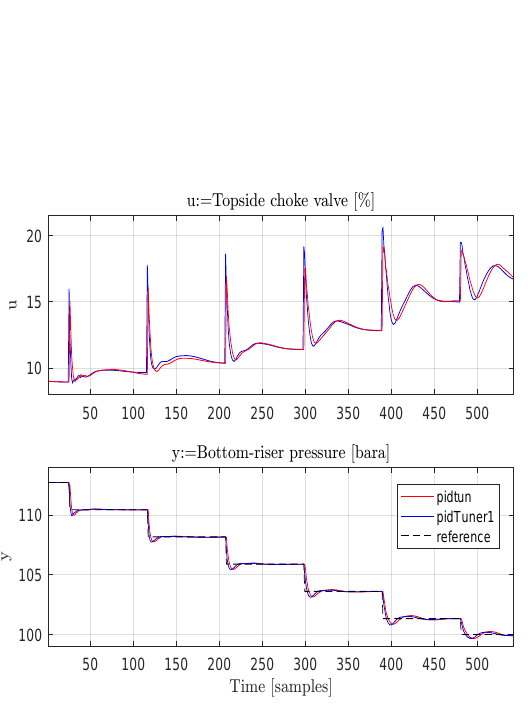
Figure 10: Example